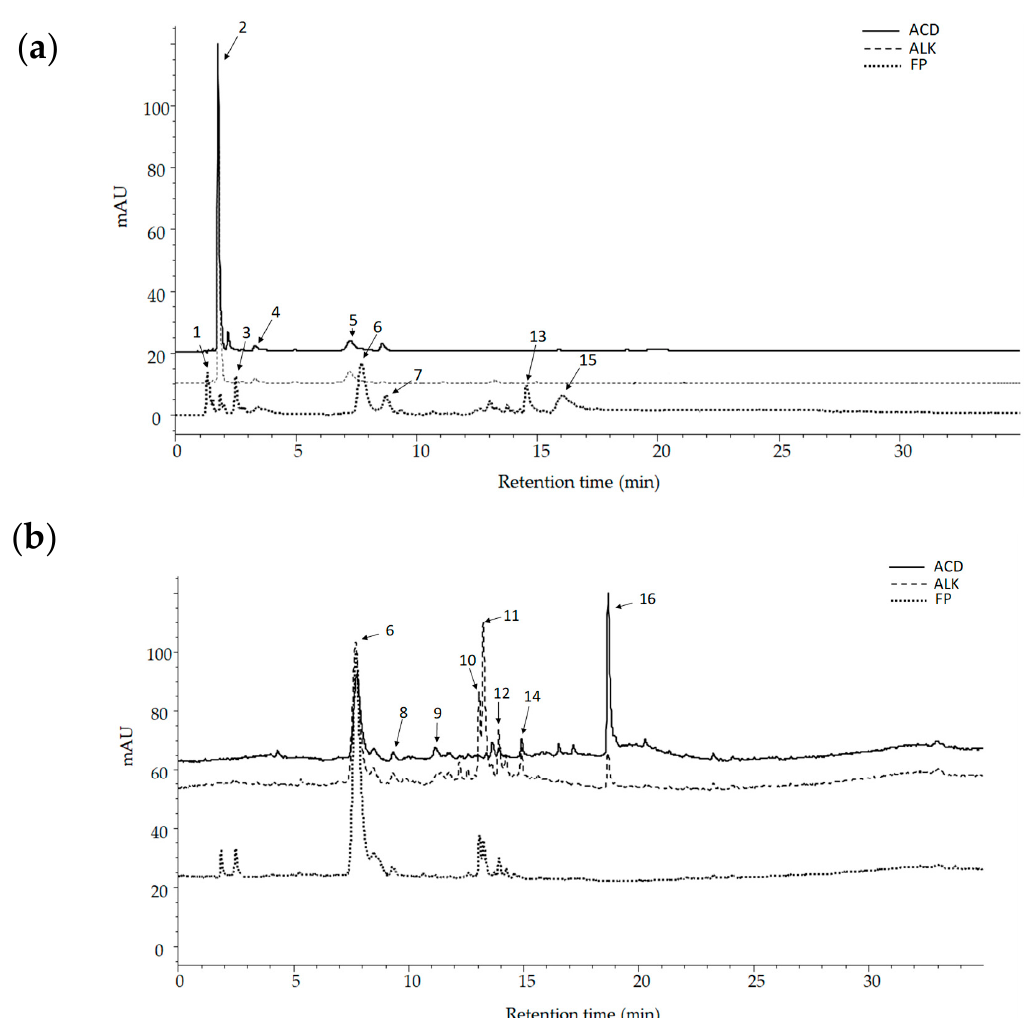
Figure 1. Base peak HPLC chromatograms at ( a ) 280 nm and ( b ) 365 nm with the identification of phenolic compounds detected in free phenolic (FP), alkaline (ALK), and acid (ACD) fractions obtained from mango cv. Ataulfo peel.